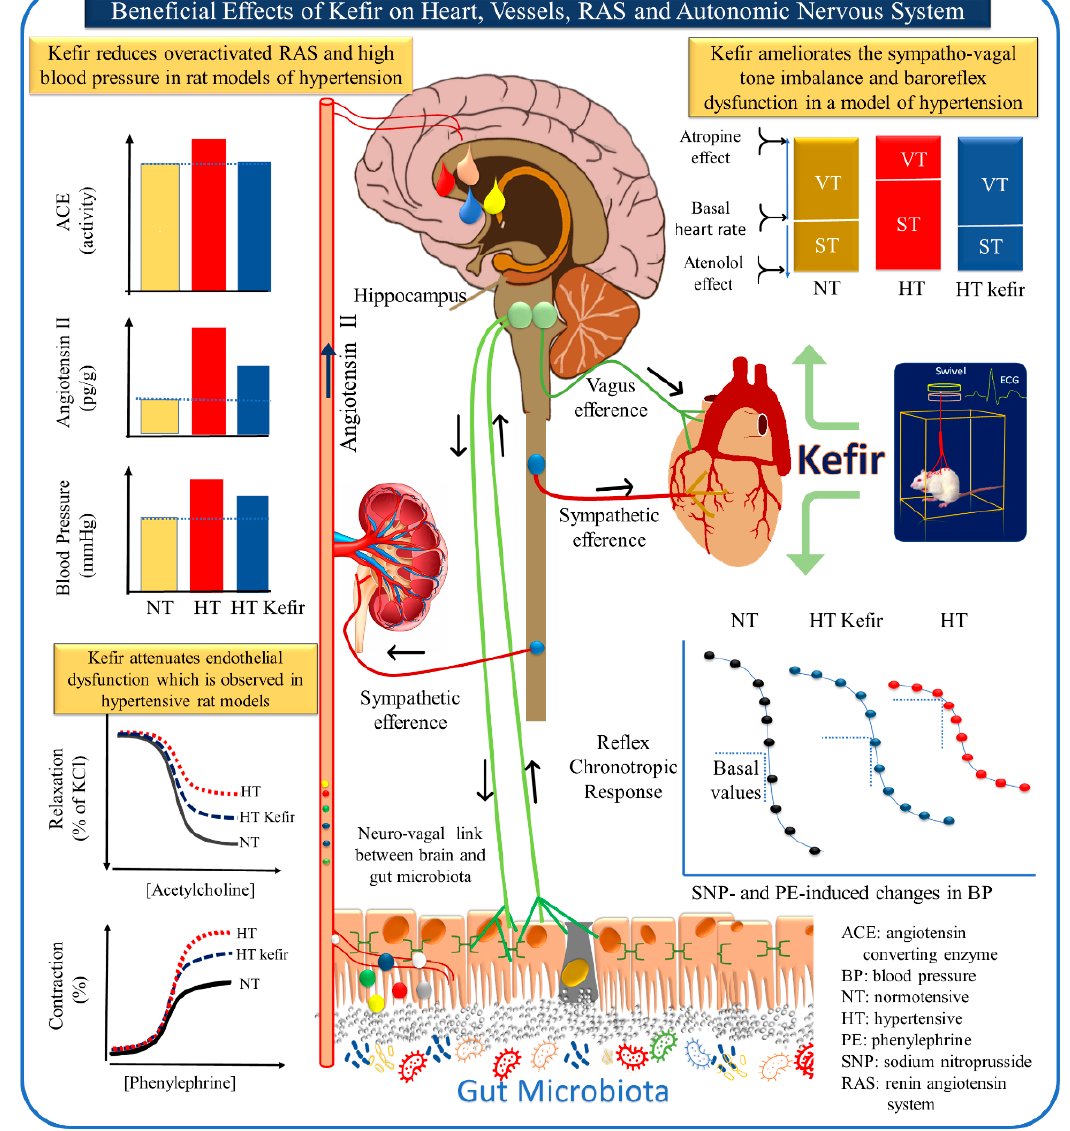
Figure 3. Gut microbiota and some relevant molecular pathways linking gut dysbiosis to cardiovascular diseases through the bloodstream and via the autonomic nervous system. The main mechanisms of the modulators include the neuroendocrine, afferent, and efferent pathways of the autonomic nervous system (vagus and sympathetic components), reactive oxygen species (ROS, represented by red circles), inflammatory markers (white and blue circles), and dietary metabolic products (short-chain fatty acids: SCFAs; lipopolysaccharide: LPS, green circles), which are delivered into the circulatory system and reach the brain, connecting integrative areas related to ND. Distinct areas (kidney, gut, heart, and brain) are represented to emphasize the protective effects of kefir based on our recent publications [14,63–65]. All images were modified and reconstructed from our previous publications. This diagram was also created by one of the coauthors of this review, a 76-year-old researcher suffering from PD for 12 years.